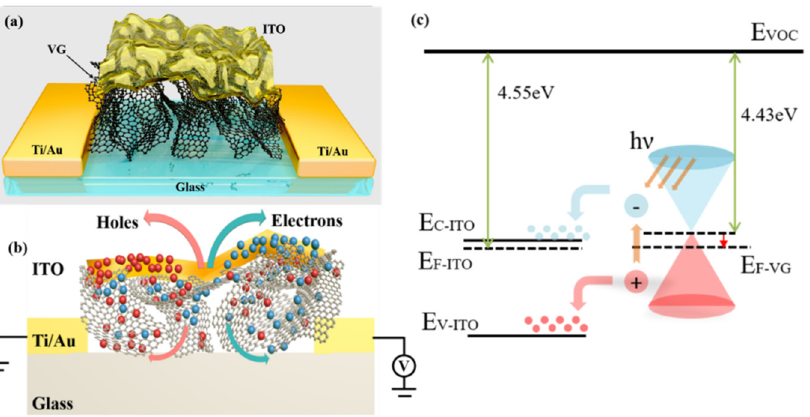
Figure 1. The VG/ITO composite structure photodetector. ( a ) Threedimensional schematic view of the composite photodetector. ( b ) Cross-sectional view of the VG/ITO composite structure photodetector together with electrical connections used to characterize the device. Blue balls represent electrons, and red balls represent holes. ( c ) Schematic of charge transfer at VG/ITO interface.